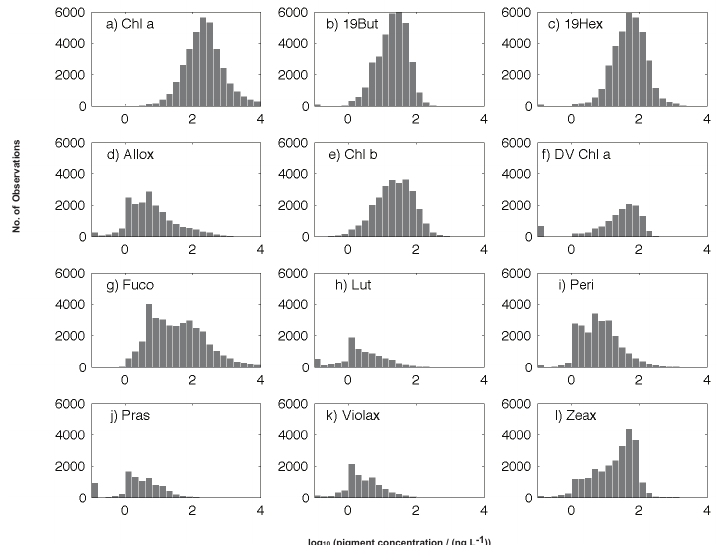
Figure 7. Number of MAREDAT pigment observations as a function of concentration (ngL − 1 ): (a) chlorophyll a (Chl a ), (b) 19’- butanoyloxyfucoxanthin (19But), (c) 19’-hexanoyloxyfucoxanthin (19Hex), (d) alloxanthin (Allox), (e) chlorophyll b (Chl b ), (f) divinyl chlorophyll a (DV Chl a ), (g) fucoxanthin (Fuco), (h) lutein (Lut), (i) peridinin (Peri), (j) prasinoxanthin (Pras), (k) violaxanthin (Violax) and (l) zeaxanthin (Zeax).